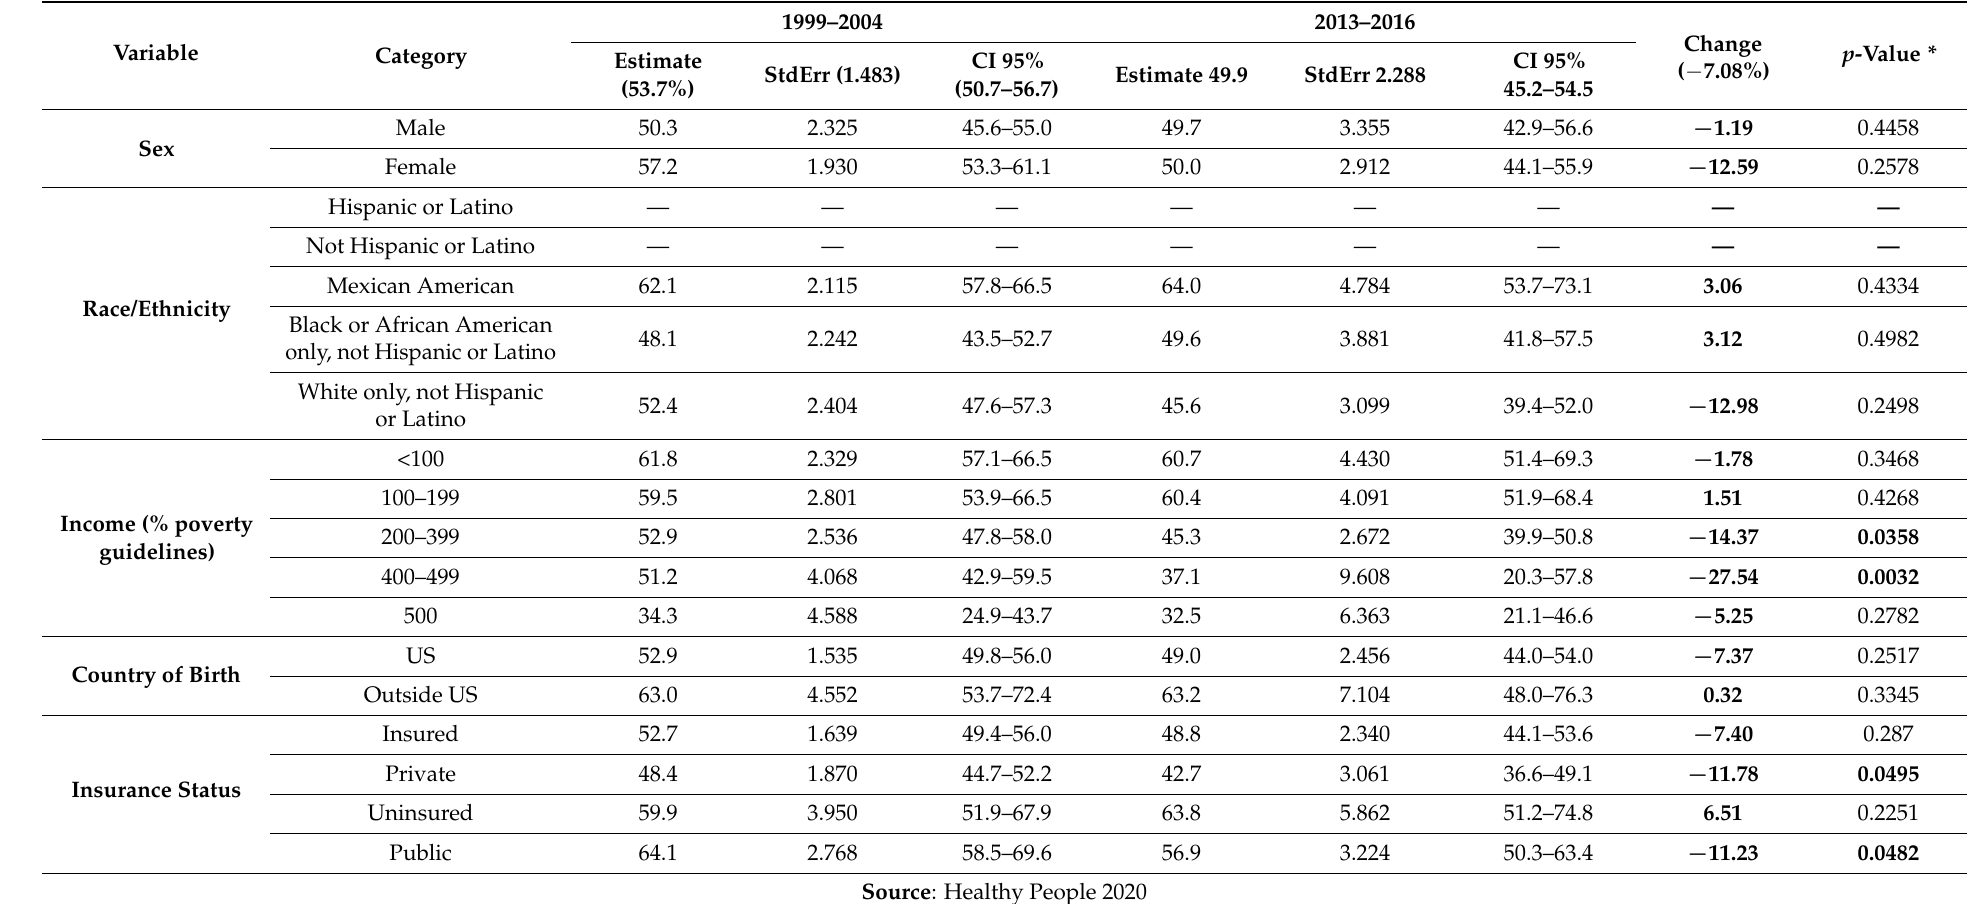
Table 4. Distribution of OH 1.3: caries 13–15 years, according to sociodemographic characteristics. Healthy People 2020. USA,